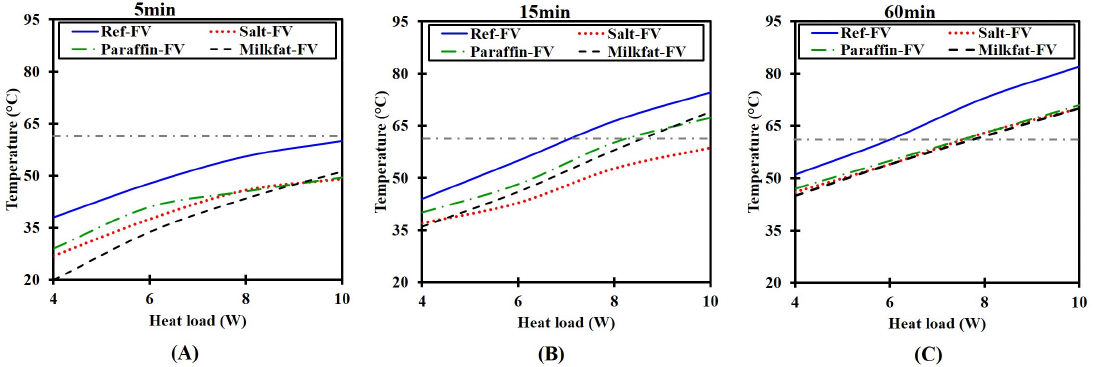
Figure 6. Average heat sink base surface temperature ( T b ) for three PCMs at 4–10 W heat loads under